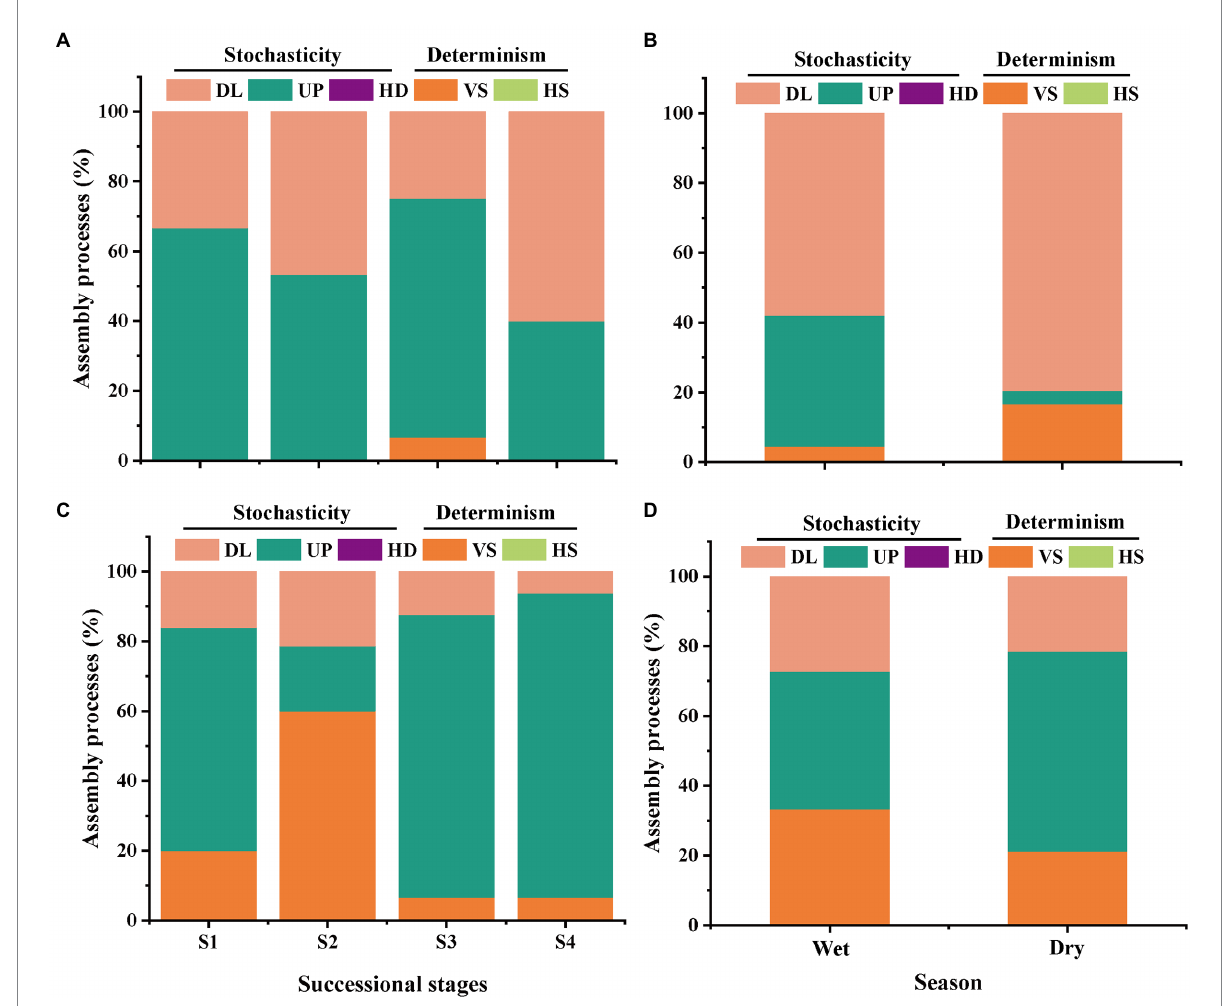
FIGURE 5 The relative contributions (%) of the community assembly processes in shaping soil bacterial (A,B) and fungal (C,D) communities in different stages of forest succession and seasons. HS, homogeneous selection; VS , variable selection; HD, homogenizing dispersal; UP, undominated process; DL, dispersal limitation. S1, initial stage; S2, early stage; S3, middle stage; S4, late